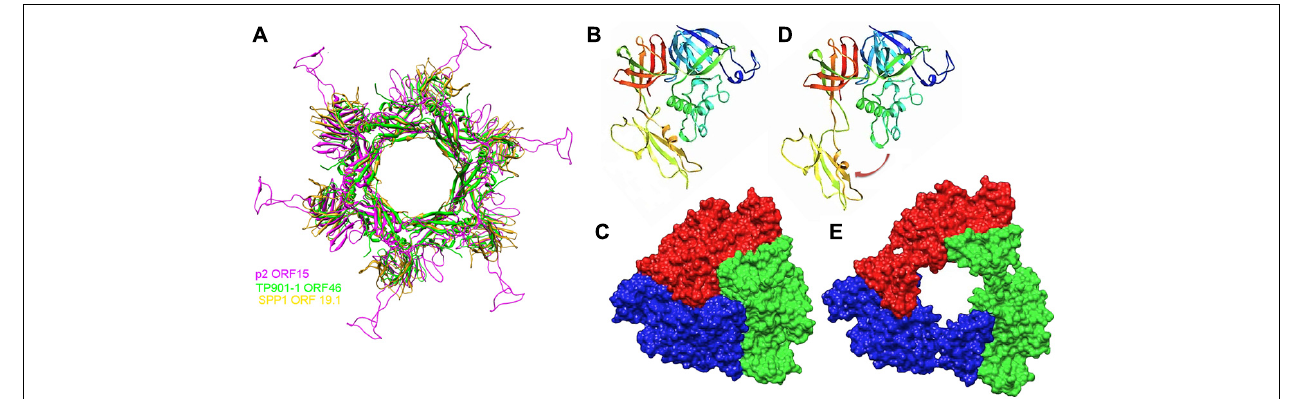
FIGURE 7 | Crystal structures of components of phages baseplates. (A) Superimposition of the Dit hexamers structures from phages TP901-1 (ORF46, green), p2 (ORF15, purple), and SPP1 (gp19.1, gold). (B) Ribbon view of the crystal structure of ORF16/Tal from the p2 baseplate in the rest form (rainbow coloring, from blue to red). (C) Surface view of the closed